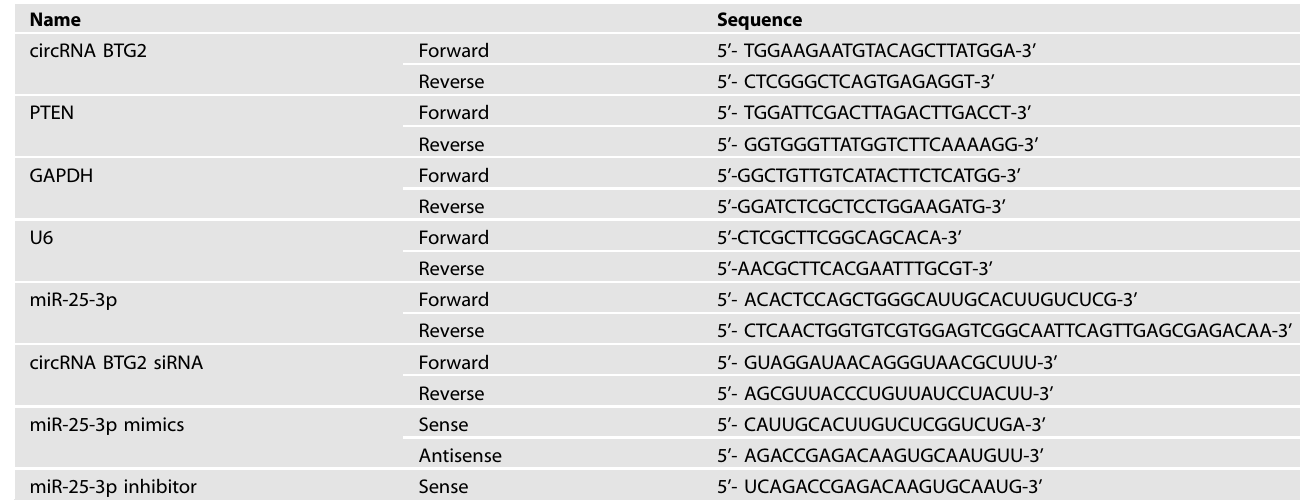
Fig. 8 Graphpical Abstract of RBP-J OE M φ -Exos-mediated glioma progression. RBP-J OE M φ -Exo enhance circRNA BTG2 expression of glioma cells. Exosomal circRNA BTG2 may suppress the progression of glioma by acting as a ceRNA to competitively bind to miR-25-3p and regulate PTEN expression. Table 2. Sequences of primers for qRT-PCR and siRNA related